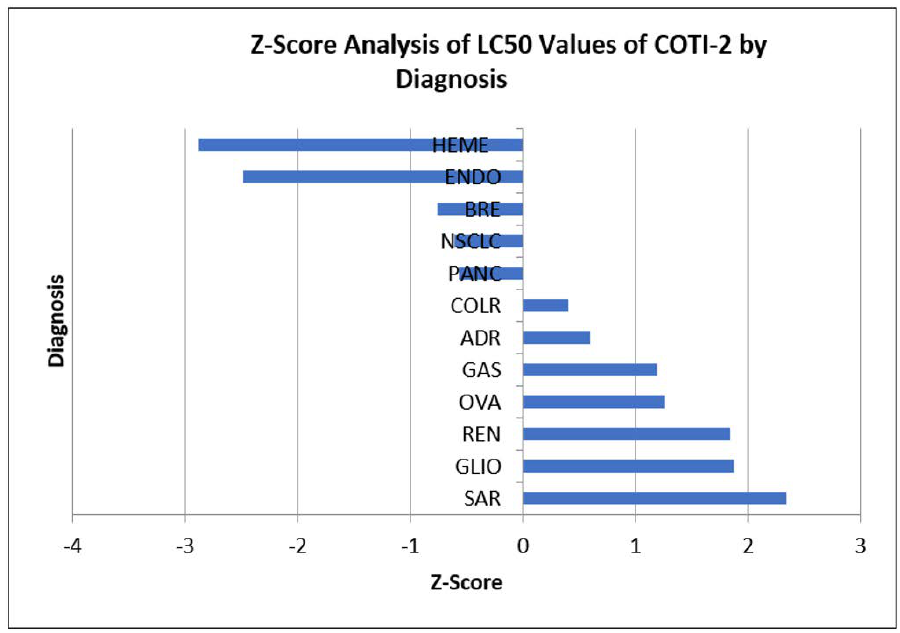
Figure 2. Lethal concentration (LC50) values were compared using Z-scores calculated by the formula Z = X − U/S, where X = Mean value, U = Sample value and S = Standard deviation. Results falling to the left of mean are more sensitive. Results falling to the right of mean are more resistant: Heme = Hematologic tumors; Endo = Endometrial; Adr = Adrenocortical; Colr = Colorectal; Panc = Pancreatic; SAR = Sarcoma; Ova = Ovarian; NSCLC = Non-small cell lung cancer; Gas = Gastric; Bre = Breast; Ren = Renal; Glio = Glioblastoma.